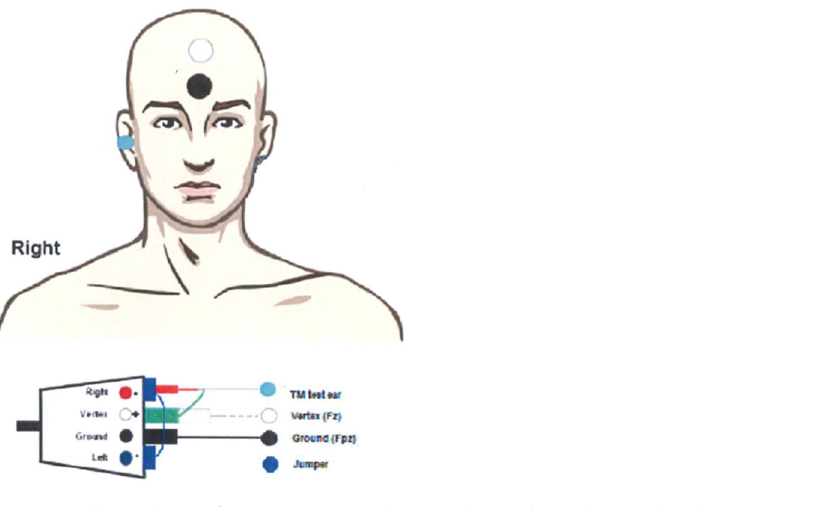
tics, Figure 1. Electrode configuration using the TM electrode and EPA4 (with permission of Inter- acoustics, 2019).